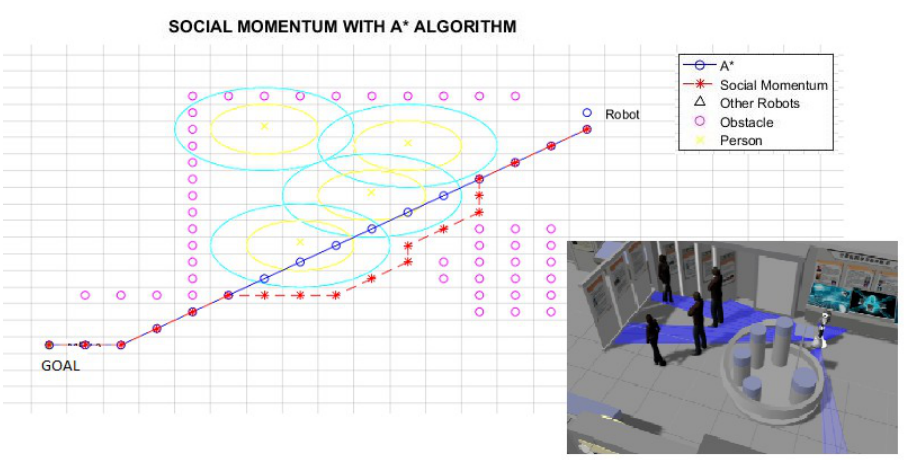
Figure 18. Path 2—Generation considering group of humans.